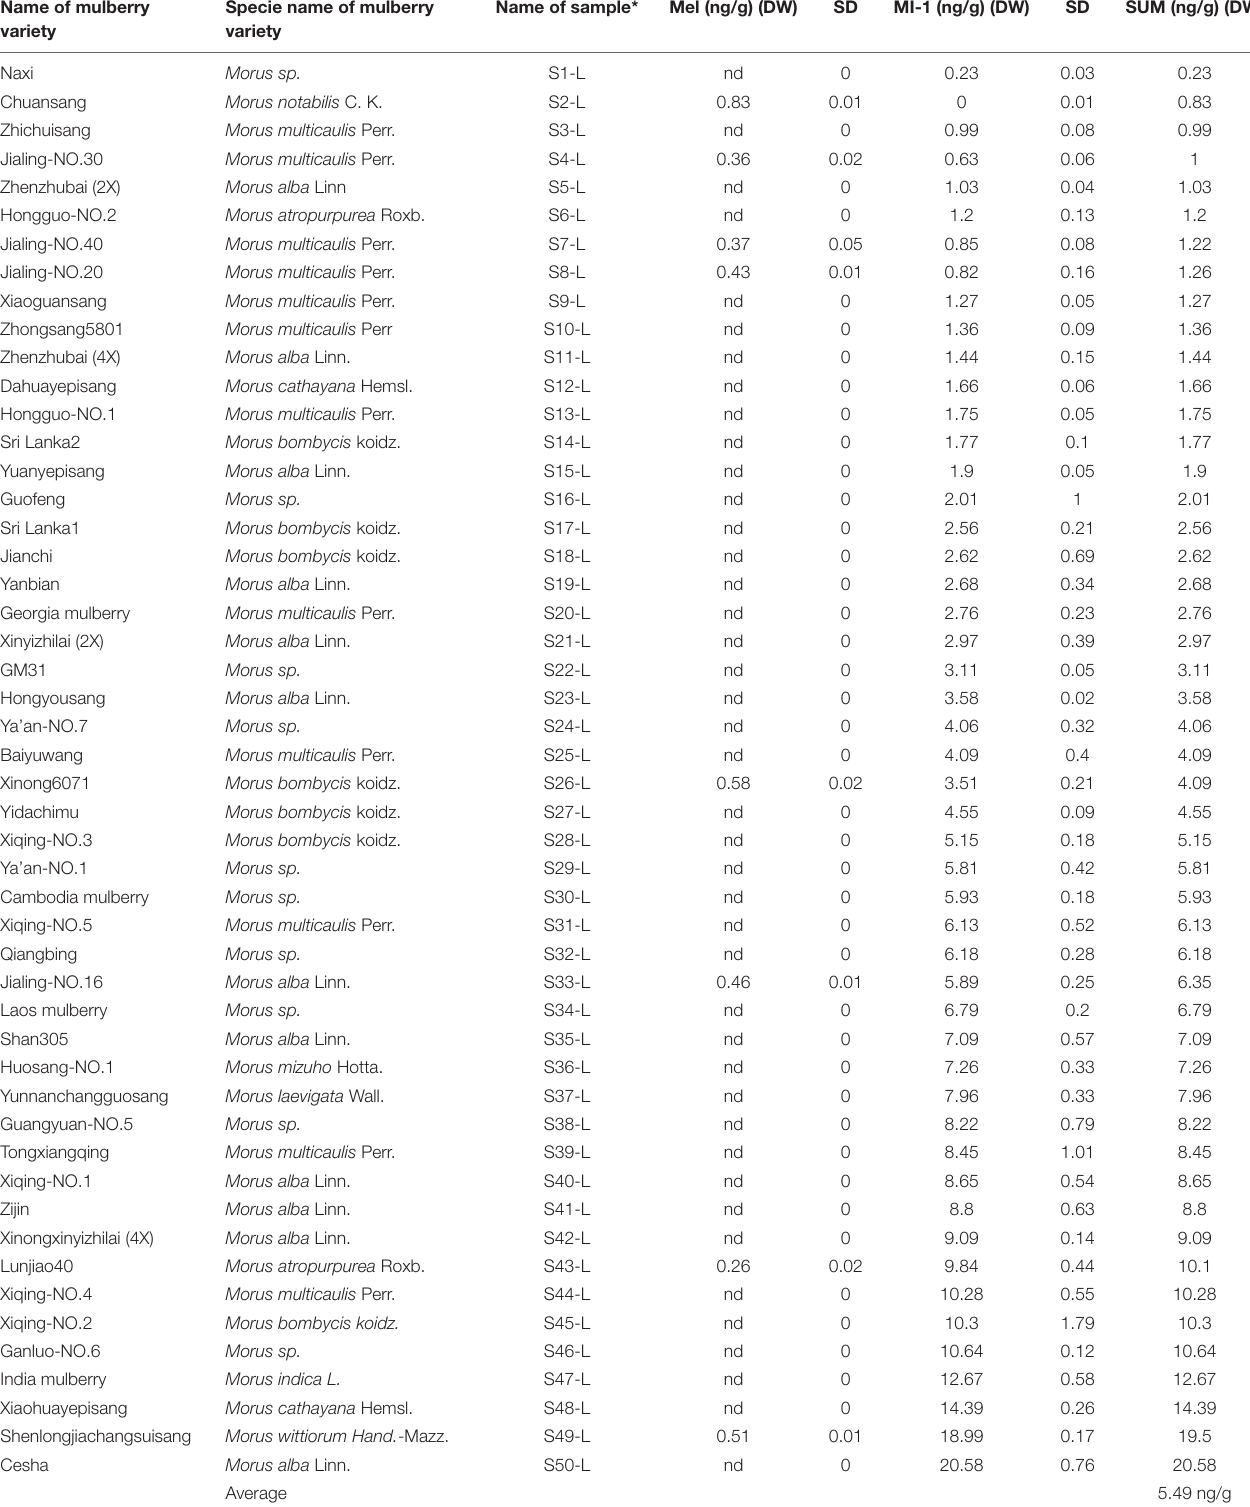
TABLE 1 | Contents of melatonin and its isomers in the mature mulberry leaves from 50 varieties harvested in May, 2015. Name of mulberry